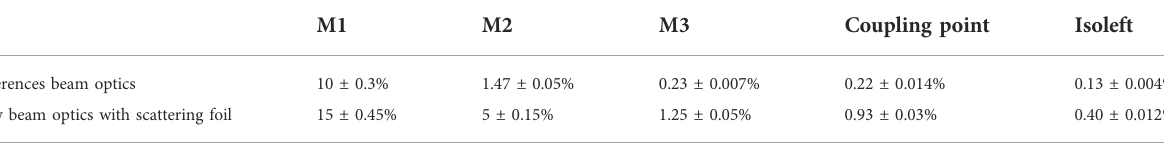
TABLE 2 Measured transmission using reference beam optics and new beam optics with scattering foil. Transmission values are from cyclotron to different locations along the